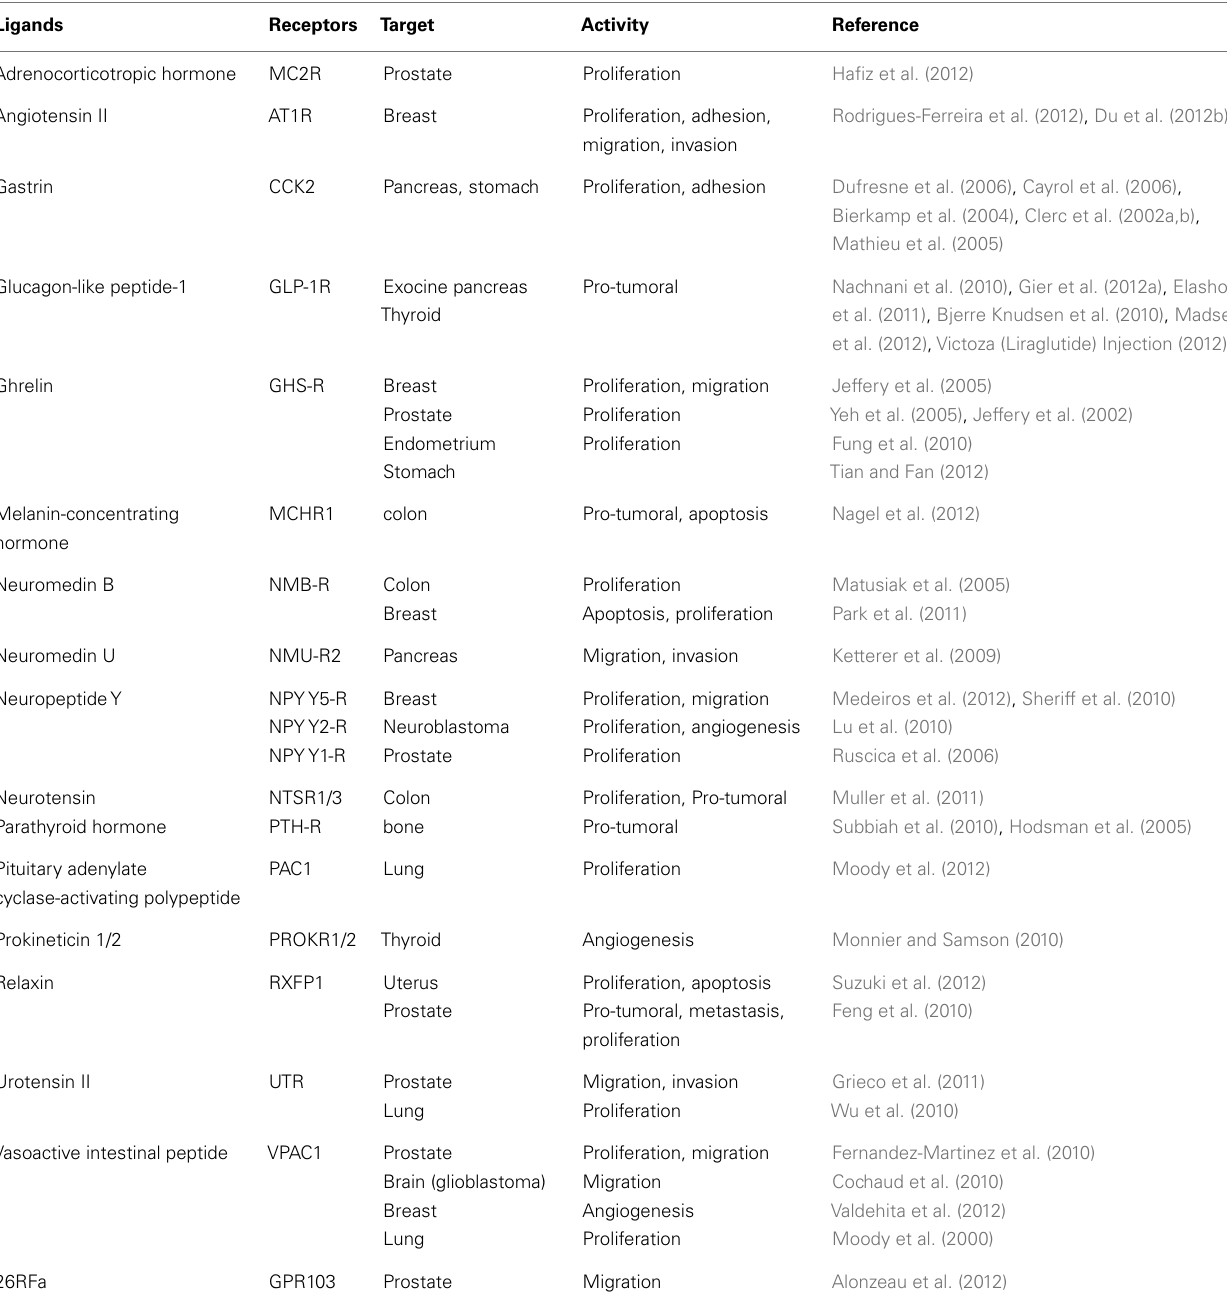
Table 2 | Examples of Neuropeptide GPCRs with pro-tumoral activities and